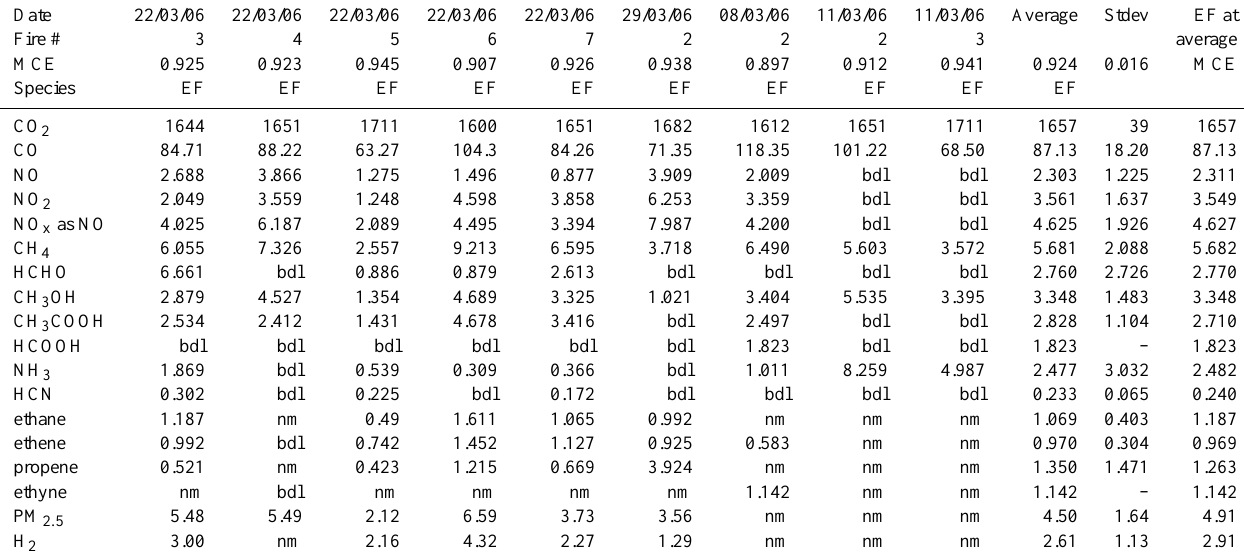
Table 3. Emission factors (EF, gkg − 1 ) and modified combustion efficiency (MCE) for tropical dry forest fires.